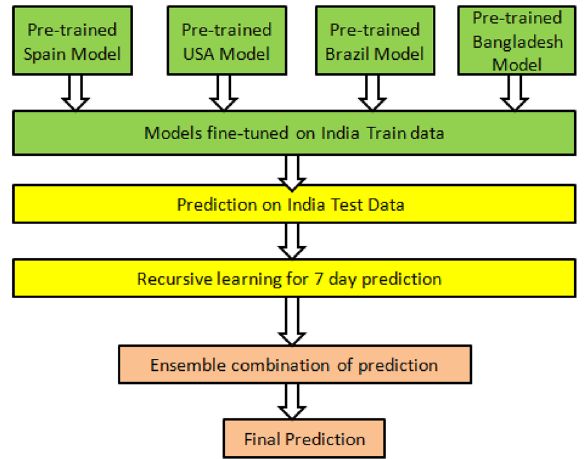
Figure 2. Flowchart of the proposed method.